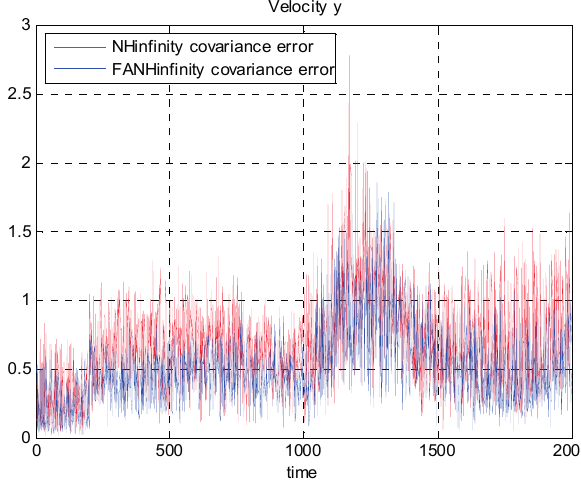
Figure 21. Velocity error covariance in y -axes using the true error.